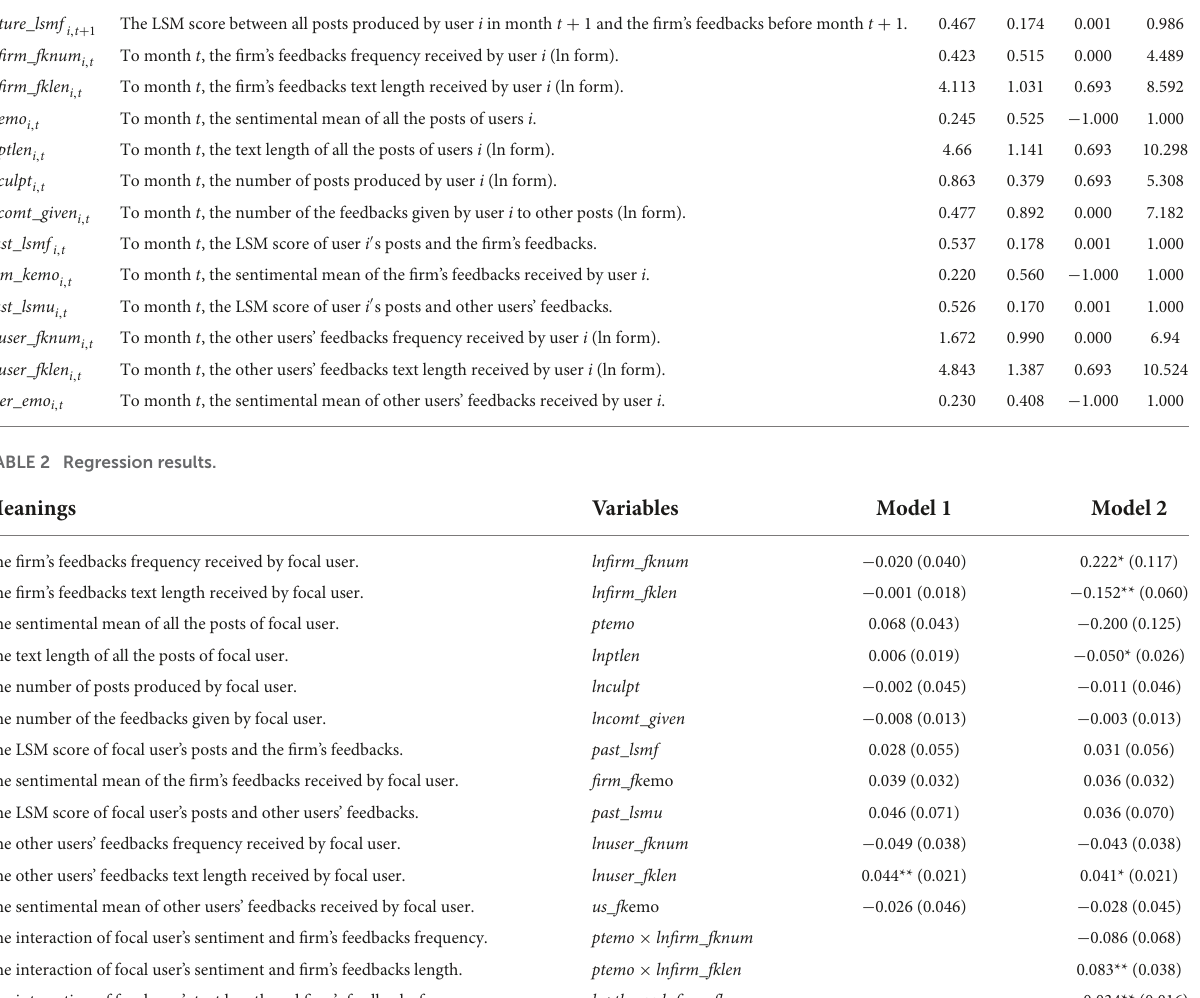
TABLE 1 Description of variables and descriptive statistics.